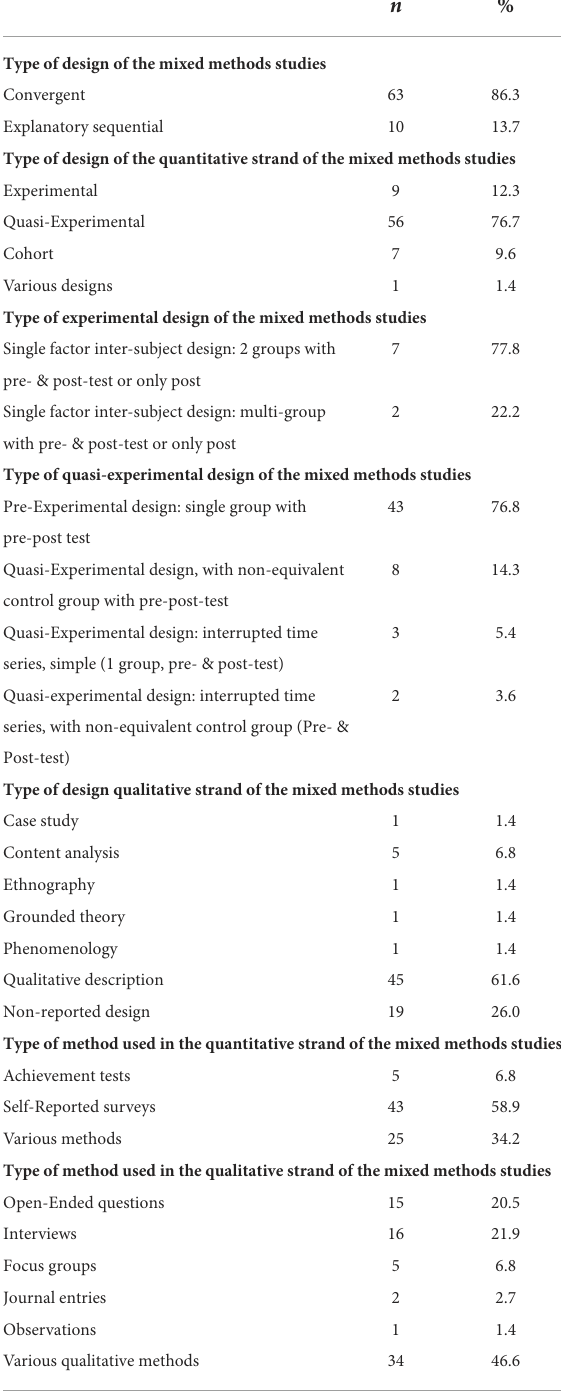
TABLE 6 Methodology of the intervention studies with a mixed-method